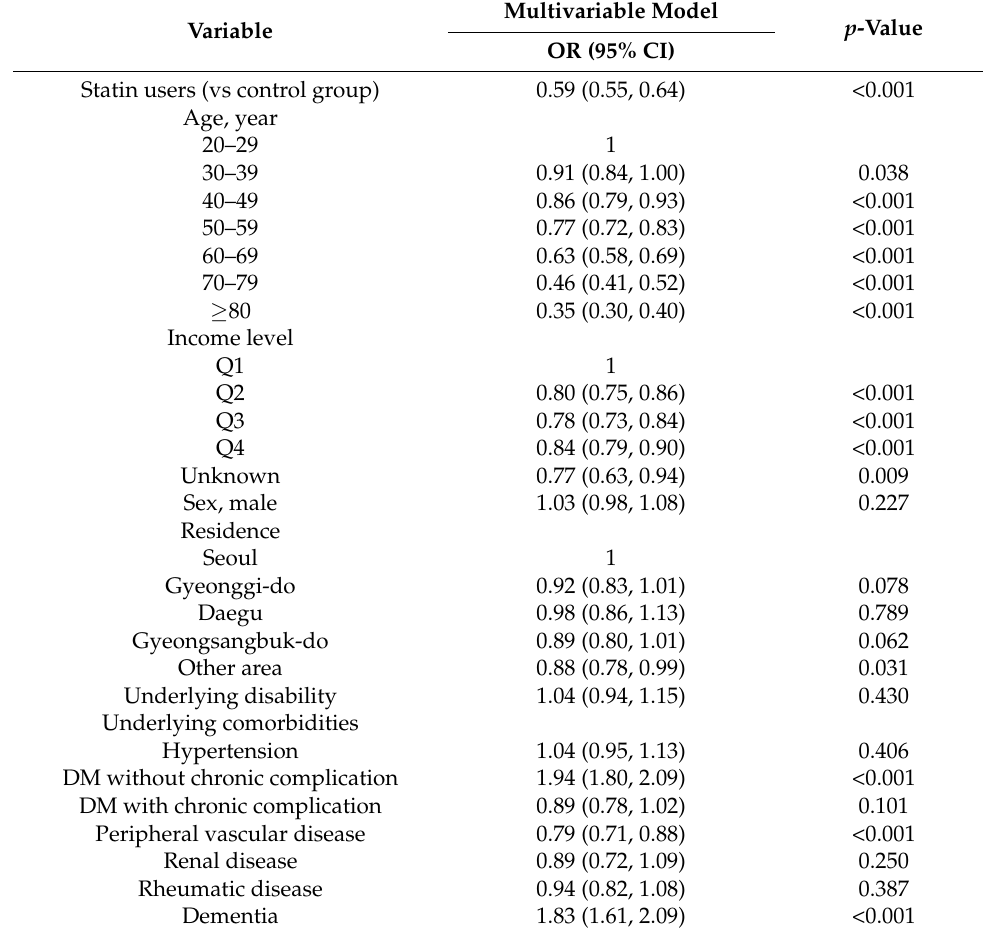
Table 3. Multivariable logistic regression model for diagnosis of COVID-19 in the entire National Health Insurance Service (NHIS)-COVID-19